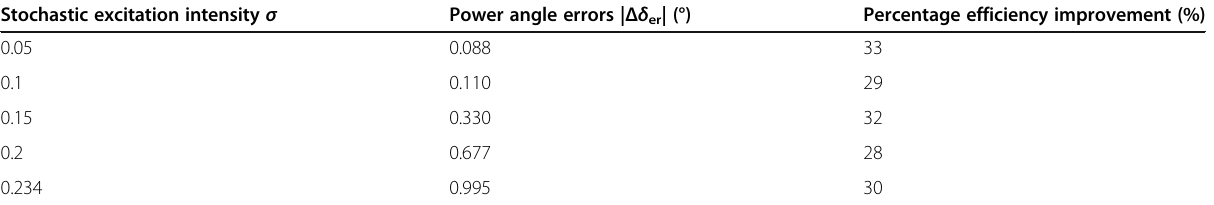
Table. 2 Power angle error and simulation efficiency when excitation intensity is less than threshold Stochastic excitation intensity σ